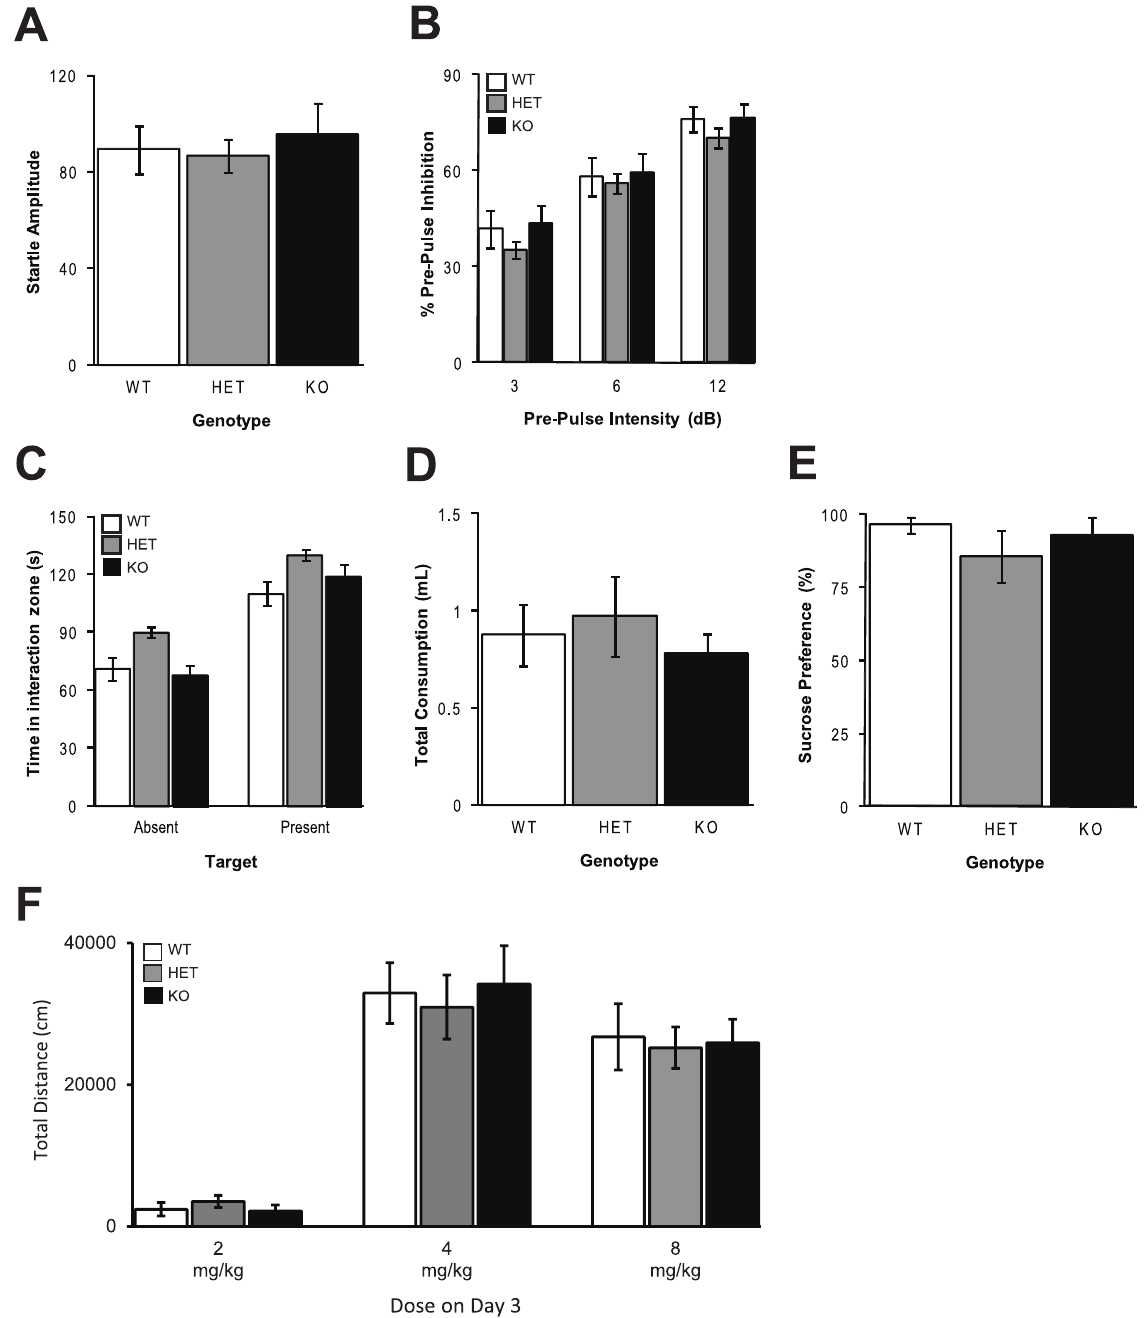
Figure 2. Behavior in Csmd1 KO mice is normal across multiple behaviors modeling aspects of schizophrenia. A) Startle response did not differ among genotypes. B) There was no significant main effect of genotype on PPI, nor was there a significant interaction between genotype and prepulse intensity. C) During the SI test all mice spent more time in the interaction zone when the target was present versus absent. The total time in the interaction zone did not differ among genotypes, nor was there a significant interaction between genotype and target presence. D) Total consumption of water + 2% sucrose did not significantly differ among genotypes in the SP test. E) Sucrose preference did not significantly differ among genotypes. F) Total distance traveled over a one-hour test after treatment with d -amphetamine (2, 4, or 8 mg/kg) did not significantly differ among genotypes. doi:10.1371/journal.pone.0051235.g002 [29]. Schizophrenic patients display reduced PPI [30,31]. WT, HET, and KO mice did not differ in startle response We assessed sensorimotor gating by measuring PPI of the startle (F[2,91] = 0.24; P = 0.78; Figure 2A). All mice displayed robust response. PPI refers to the ability of a weak, initial stimulus PPI (Figure 2B). As expected, the magnitude of PPI significantly (prepulse) to inhibit the response to a subsequent startling stimulus